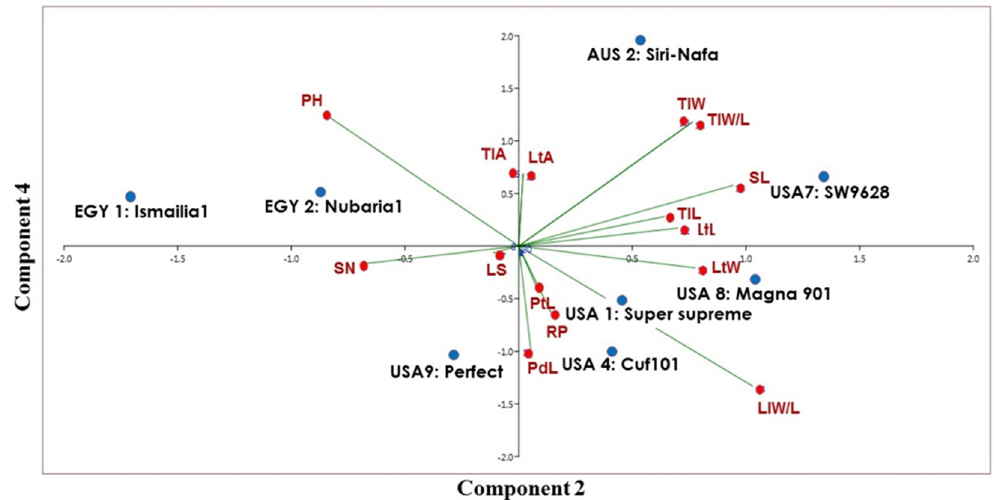
Figure 8. Biplot displays a cluster tree illustrating the genetic distance, based on the analysis of 15 morpho-agronomic traits for eight M. sativa cultivars using the Euclidean distance and the UPGMA algorithm in the PAST software.